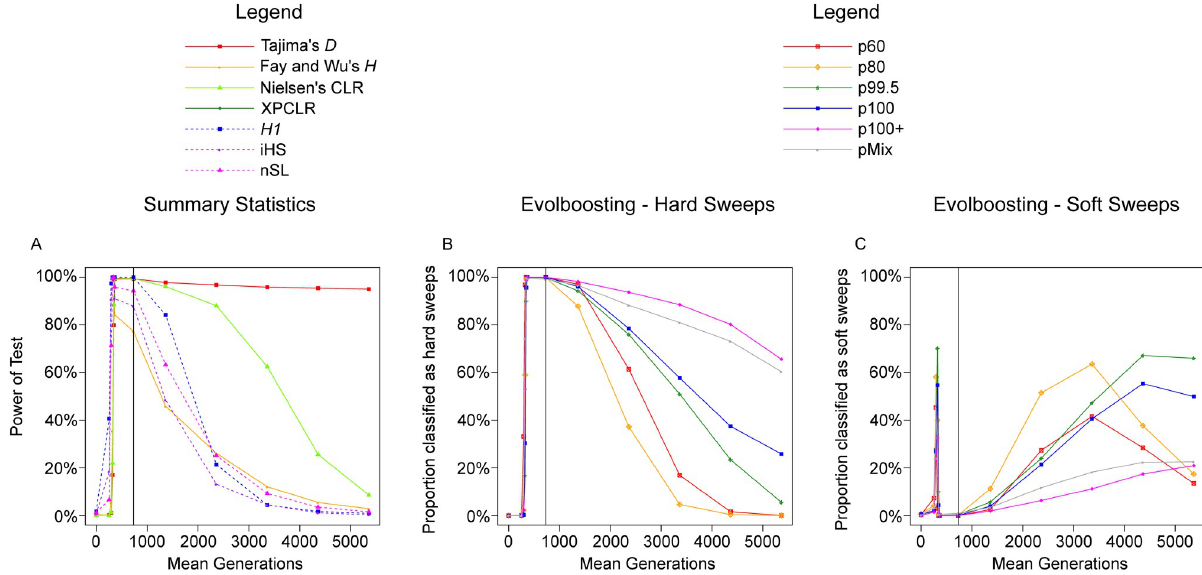
Fig 4. Full-locus simulation: The detection rate of various methods in a panmictic scenario. The proportion of samples detected as selective sweeps by various methods, under the scenario m 0 G . The vertical line indicates time of 100% fixation. A. Power of seven summary statistics; dashed lines indicate haplotype-based methods. B. Proportion detected by six EvolBoosting predictors correctly as hard sweeps. C. Proportion detected by six EvolBoosting predictors incorrectly as soft sweeps. See S3 Fig for a zoomed-in version for early stages.